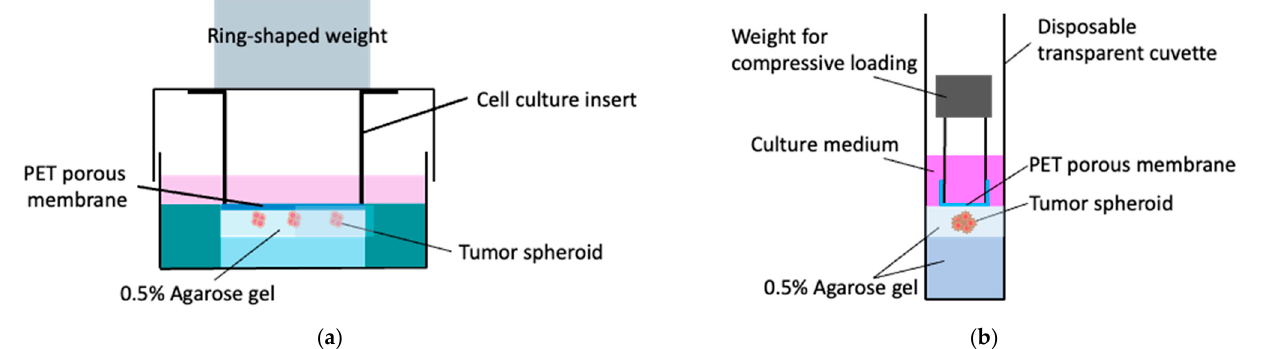
Figure 2. Tumor spheroid culture subjected to external compressive stress using transparent PET membrane and ring-shaped weight. ( a ) Petri-dish-based culture and ( b ) cuvette-based culture.